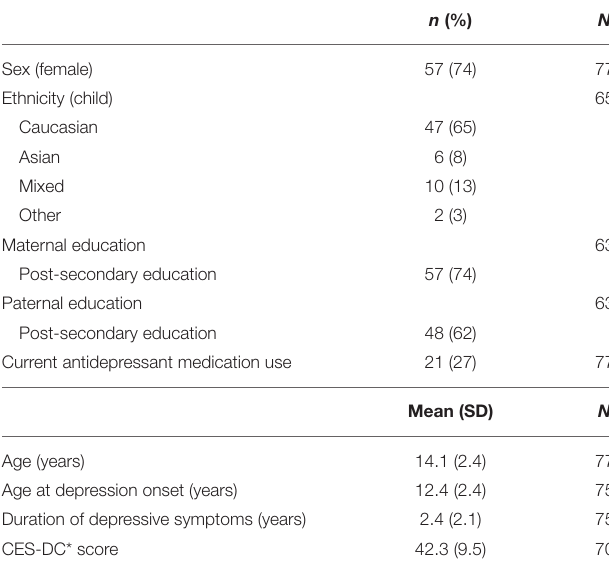
TABLE 1 | Participant demographic and depression characteristics.